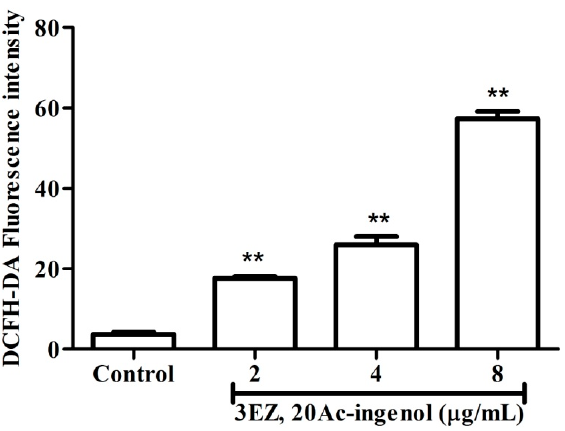
Figure 5. The effects of 3EZ, 20Ac-ingenol on ROS generationin L-O2 cells using DCFH-DA staining by laser scanning confocal microscope. Quantification of intracellular ROS fluorescence intensity were analyzed and expressed. Data are presented as mean ± SD from triplicate samples, ** P < 0.01 compared with control group.